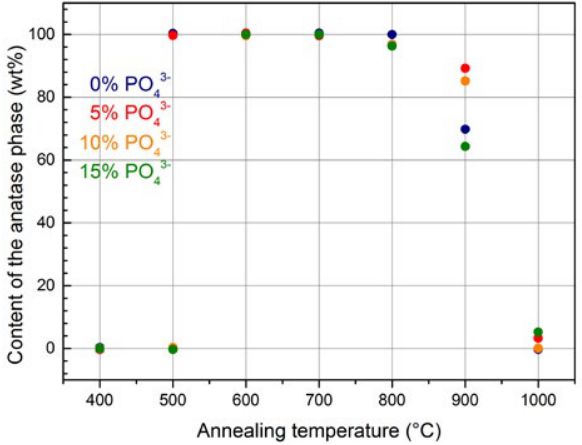
Figure 7. Evolution of the recorded diffraction patterns with an increasing annealing temperature (a: undoped TiO doped with 5 mol% of phosphate